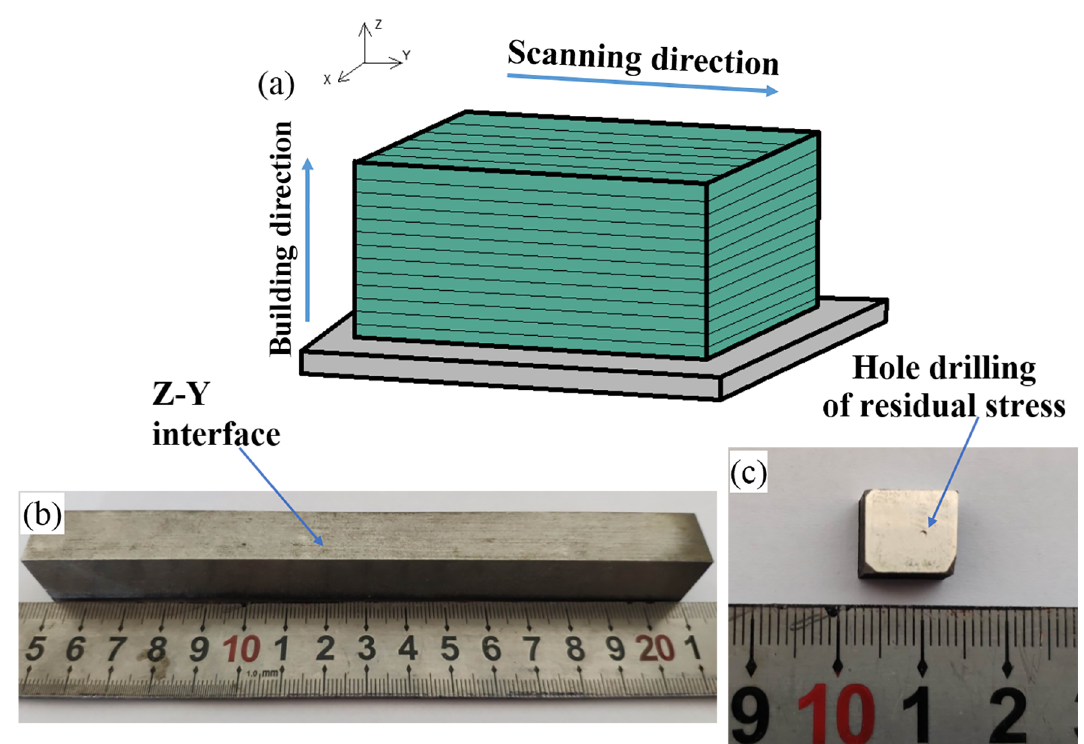
Figure 1. The schematic of Inconel 718 Ni-based alloys fabricated by SLM. (a) The building schematic of alloys; (b) The image of the components produced; (c) The image of hole drilling of residual stress